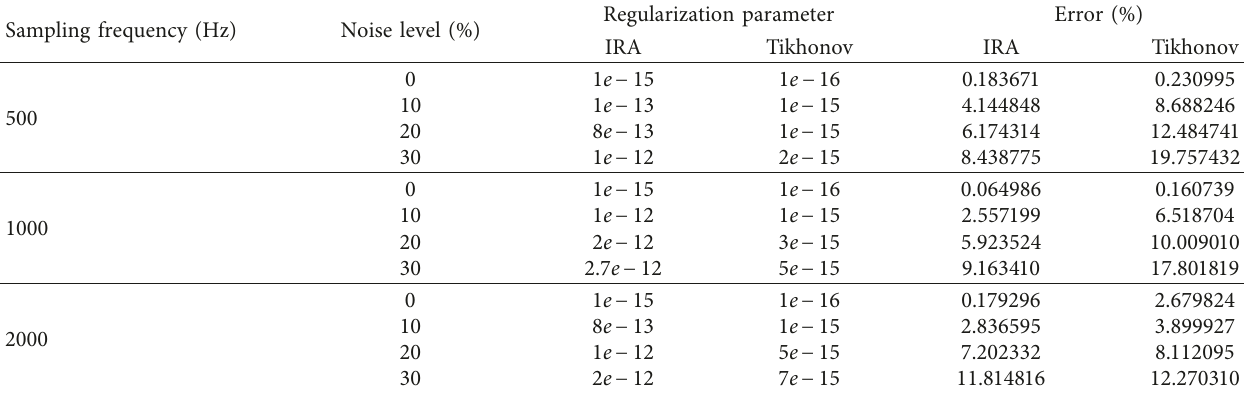
Figure 6: Relative errors identified by the responses with noise level of 20%: (a) impact load and (b) harmonic load. Table 1: Regularization parameters and relative accumulation errors of the impact